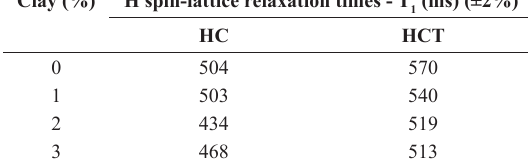
Table 2. Values of proton spin-lattice relaxation times for the samples prepared with chloroform (HC) and chloroform/toluene